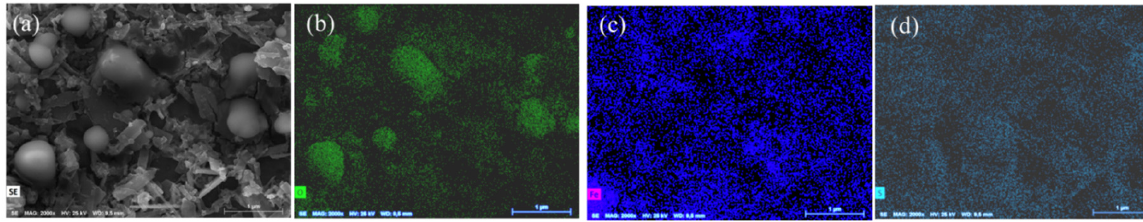
Figure 2. EDX mapping images of ABT/ δ -FeOOH material (a) SEM image corresponding to (b) Oxygen, (c) Iron and (d) Sulfur elements.